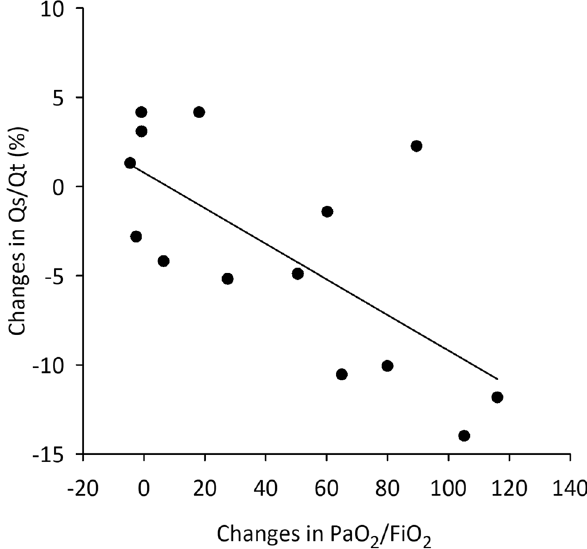
Figure 5. Correlation between the changes in PaO 2 /FiO 2 and changes in Qs/Qt occurring when changing from supine to prone position. The solid line indicates the linear